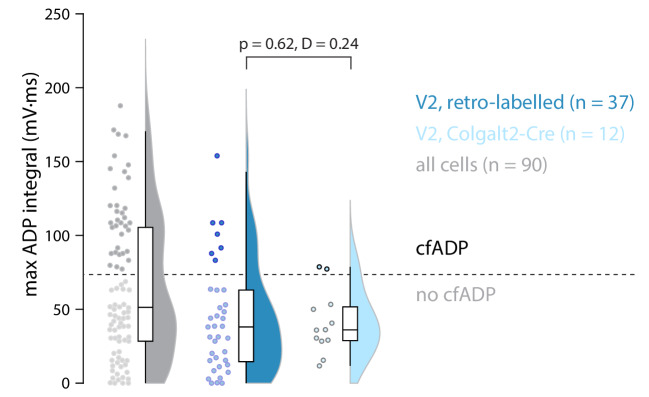
Maximum ADP integral for all cells including V1 (grey), retro-labelled cells recorded from V2m (blue), and V2m cells labelled in the Colgalt2-Cre mouse line (cyan).p and D value are shown for a two-sample Kolmogorov-Smirnov test. All cells recorded during this study from Colgalt2-Cre animals are included.